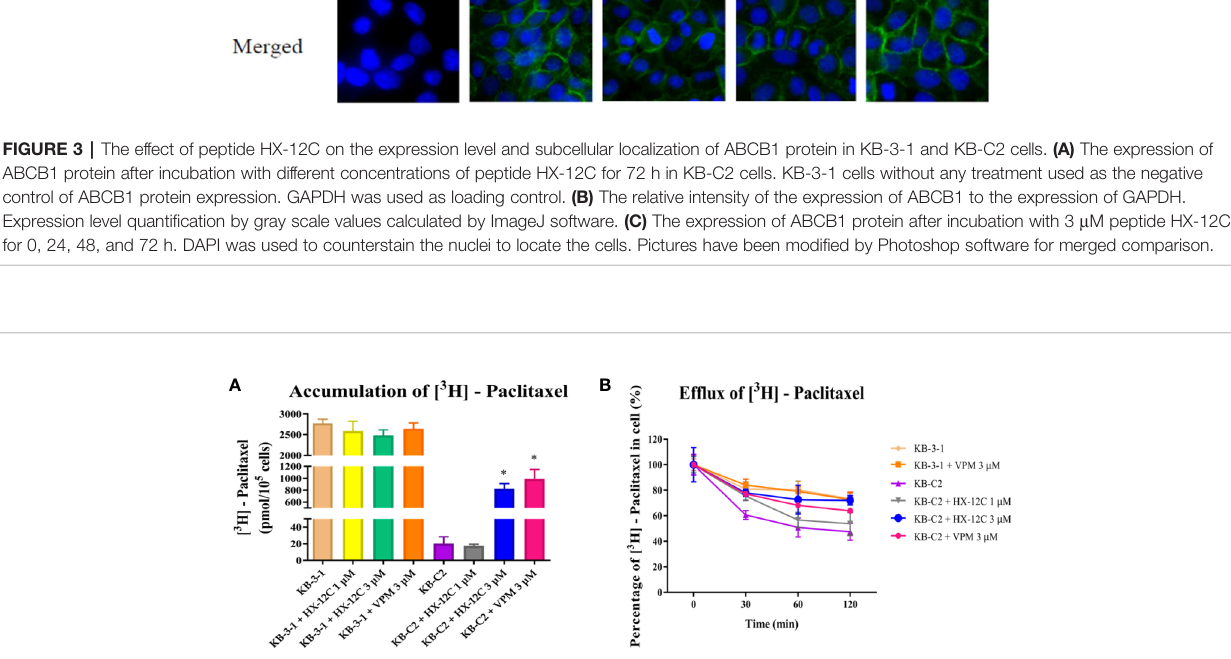
FIGURE 4 | The accumulation and ef fl ux activity of peptide HX-12C in ABCB1-overexpressing KB-C2 cells and their parental KB-3-1 cells. (A) Effects of peptide HX-12C on intracellular accumulation of [ 3 H]-paclitaxel in ABCB1-overexpressing KB-C2 cells and their parental KB-3-1 cells. Columns with error bar represent mean ± SD. *, represents p < 0.05, compared to the KB-C2 control group. VPM, verapamil. (B) Effects of peptide HX-12C on ef fl ux of [ 3 H]-paclitaxel in ABCB1- overexpressing KB-C2 cells and their parental KB-3-1 cells. VPM, verapamil. The points with error bars represent the mean ± SD from three independently repeated